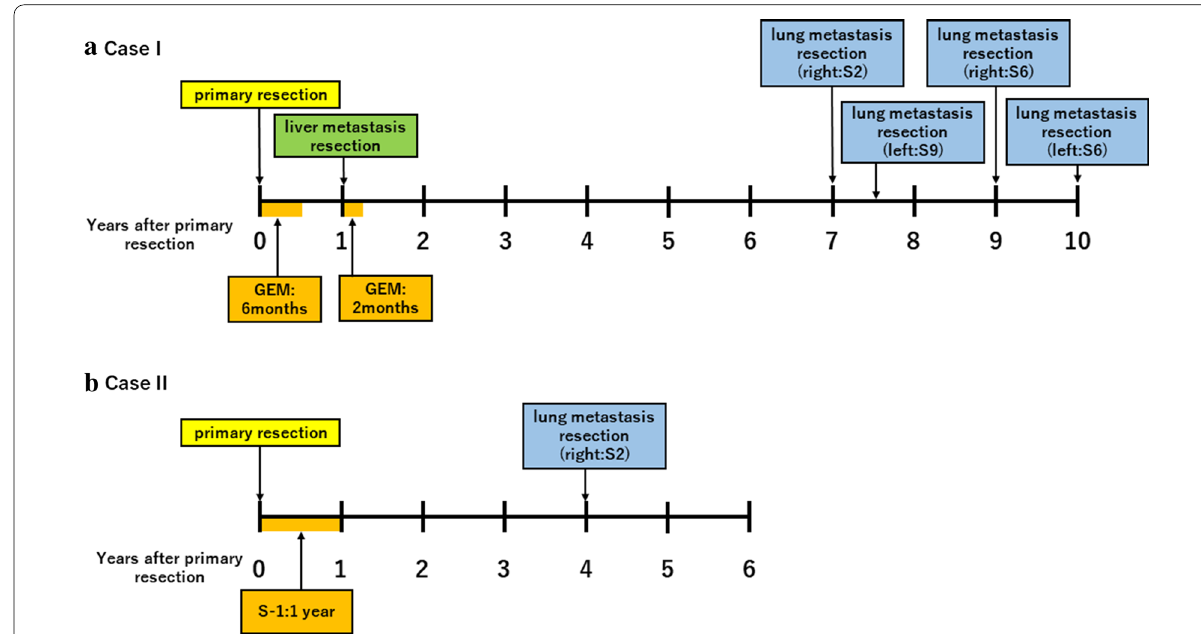
Fig. 2 a Summary of the course of the case 1. b Summary of the course of the case 2